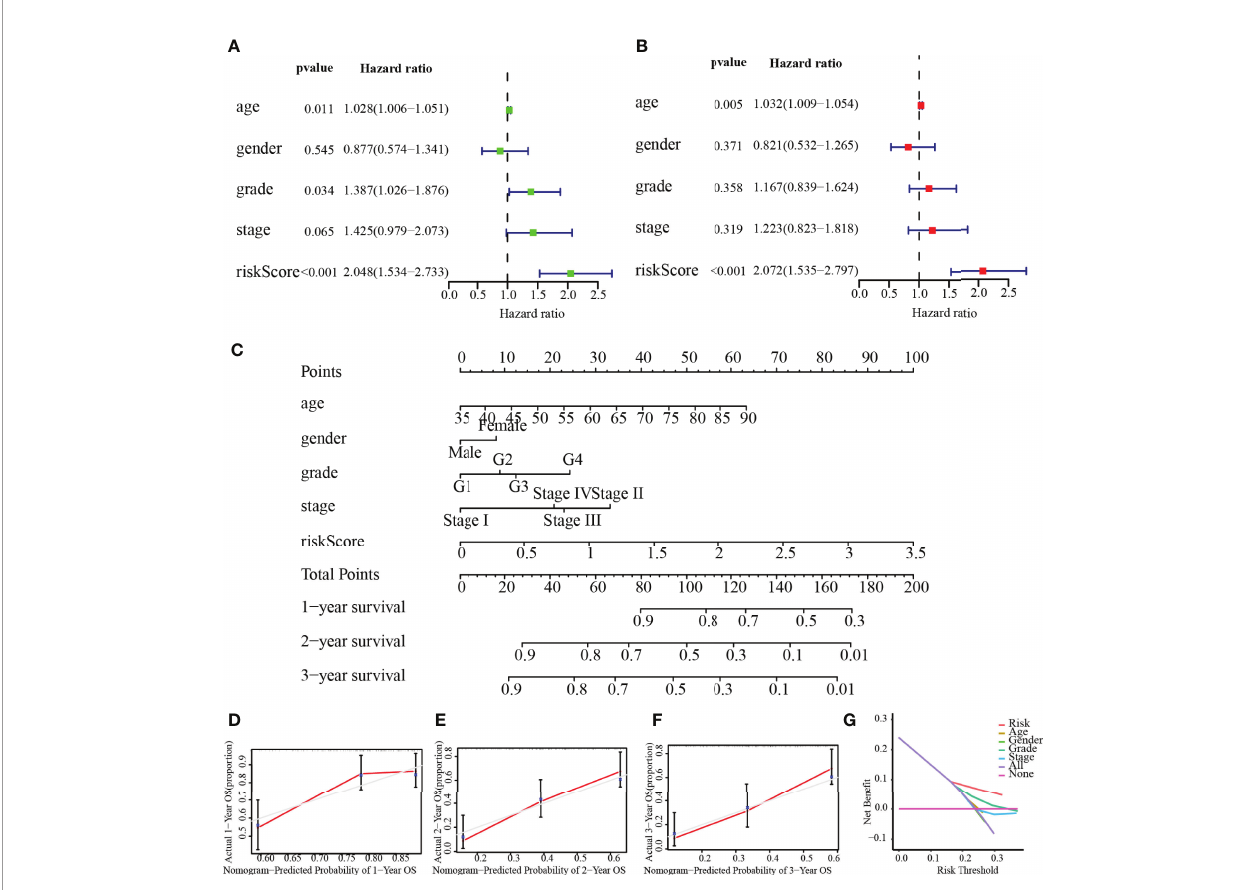
FIGURE 8 | Independent prognostic value of risk score. (A) Univariate analysis. (B) Multivariate analysis. (C) Nomogram based on the signature for PC patients at 1/ 2/3-year. (D – F) Calibration plots of the nomogram at 1, 2, and 3 years. (G) DCA of this prognostic